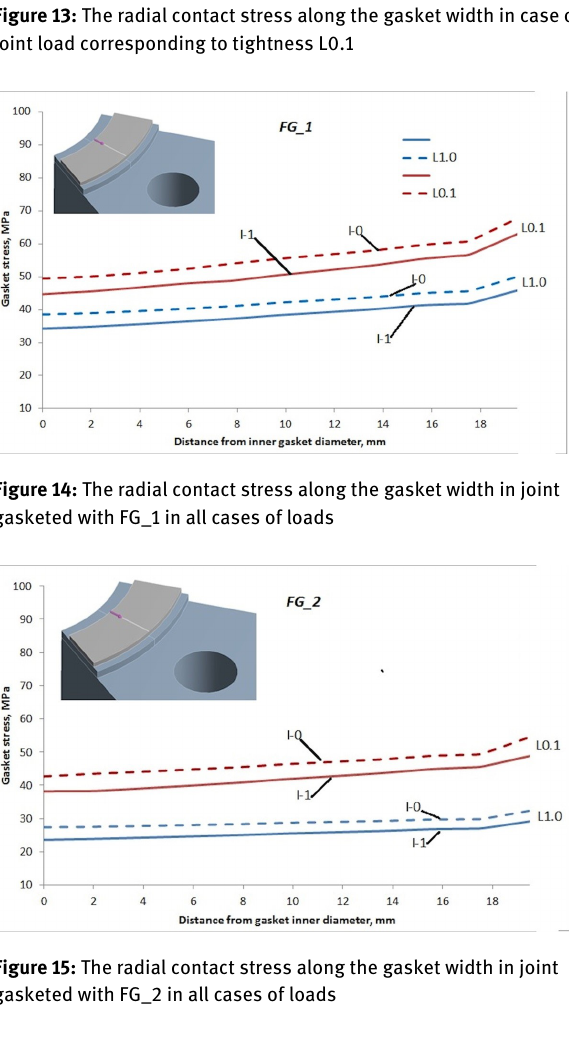
were in the acceptable range. Moreover, the tables contain the load increase in the bolt and the rotation angle of the flange. The load increase of the bolts in I-1 state equals, on average, 1kN and is the result of the hydrostatic force – in line with the formula (3). To better illustrate the results of the calculations in figure 17 the bar charts of the values of safety factors and rotation angle of the flange